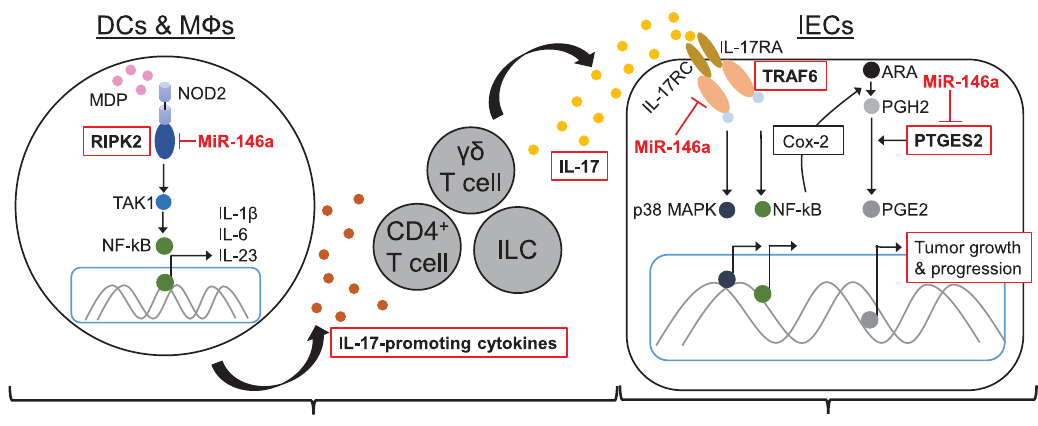
Fig. 7 Molecular mechanisms involved in miR-146a-mediated prevention of tumor-promoting in fl ammation in CRC. Our data demonstrate miR-146a prevents intestinal in fl ammation and CRC development by two interlinked mechanisms: (1) by limiting myeloid cell-mediated in fl ammatory IL-17 production; and (2) by inhibiting tumorigenic IL-17R signaling in IECs. Speci fi cally, miR-146a targets RIPK2 in DCs/M Φ s and limits NOD2 signaling, thereby limiting IL-17-promoting cytokine secretion and induction of IL-17 producers in the colon. In addition to limiting IL-17 levels, miR-146a interferes with tumorigenic IL-17R signaling within IECs by targeting TRAF6, thereby inhibiting p38 MAPK and NF- κ B signaling. We also show that miR-146a in IECs may reduce PGE2 in the tumor microenvironment to further suppress CRC growth by targeting IL-17R-induced Cox-2 and by directly inhibiting PTGES2, an enzyme responsible for PGE2